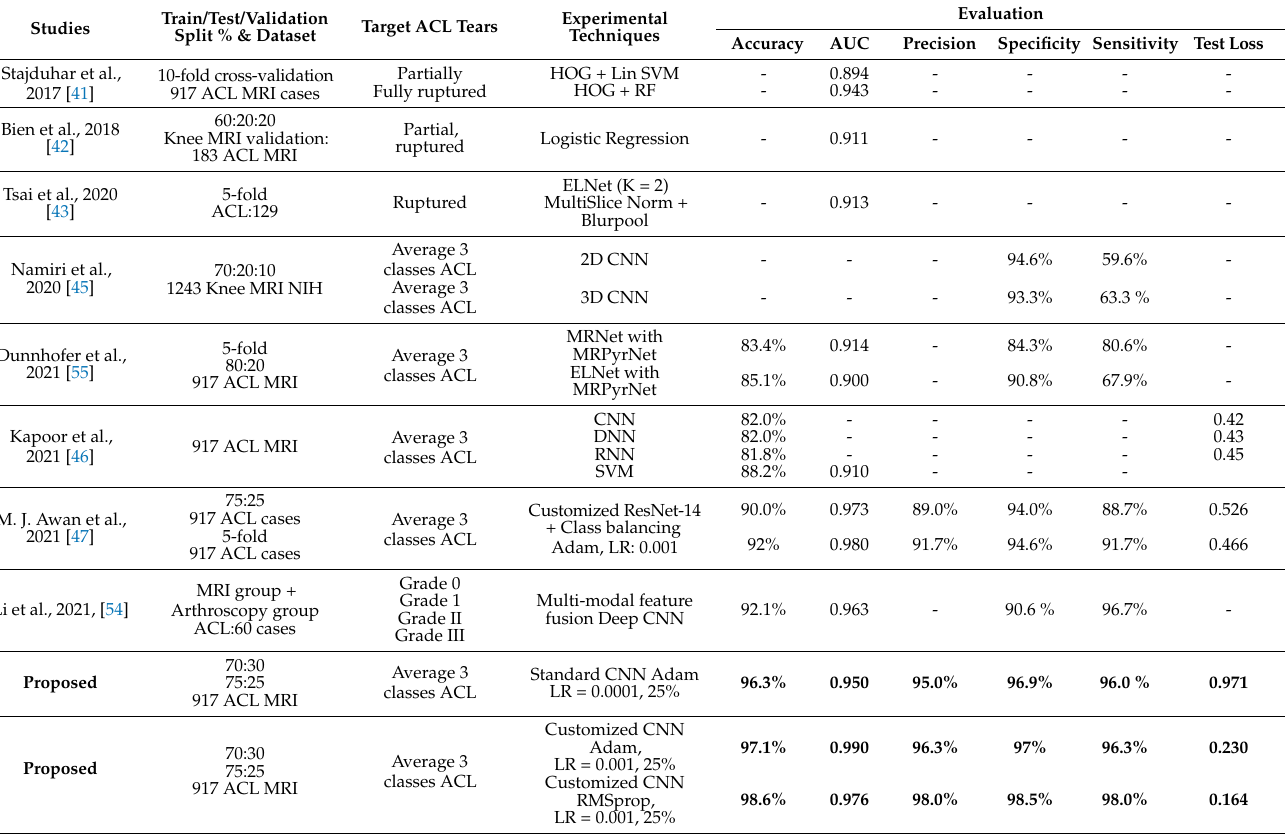
Table 3. Comparison of state-of-the-art works with our proposed